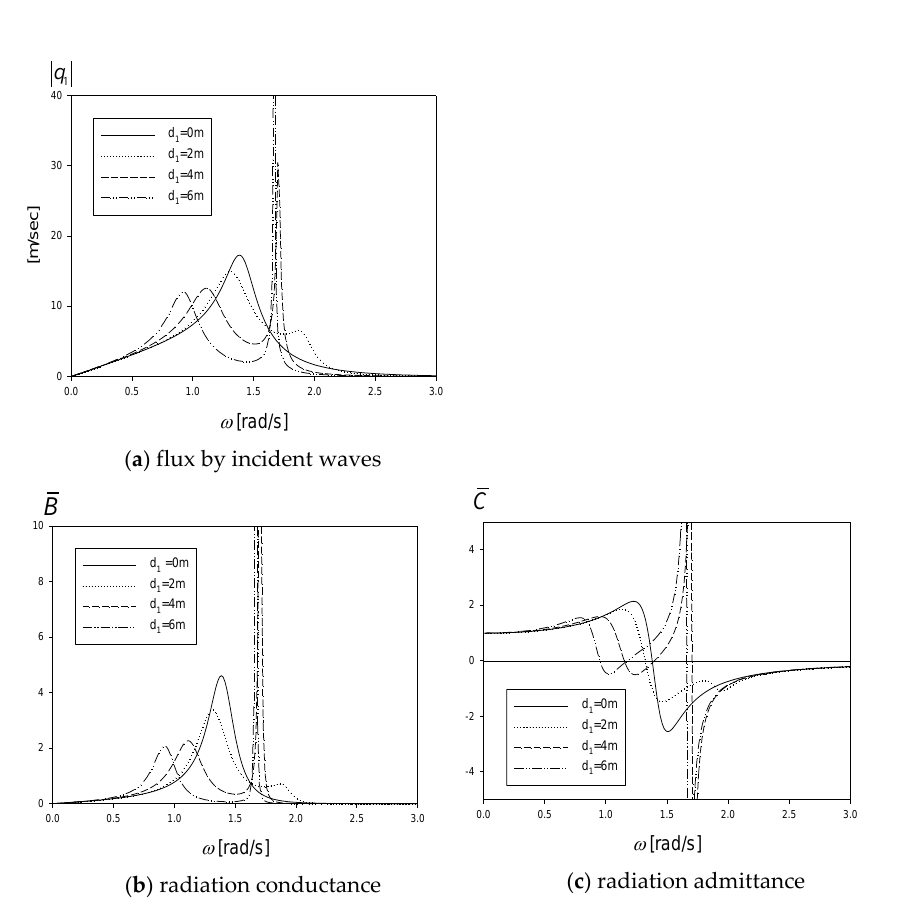
present inside the oscillating system. As the barrier height increases, both the peak value and peak frequency at the first resonance decrease.